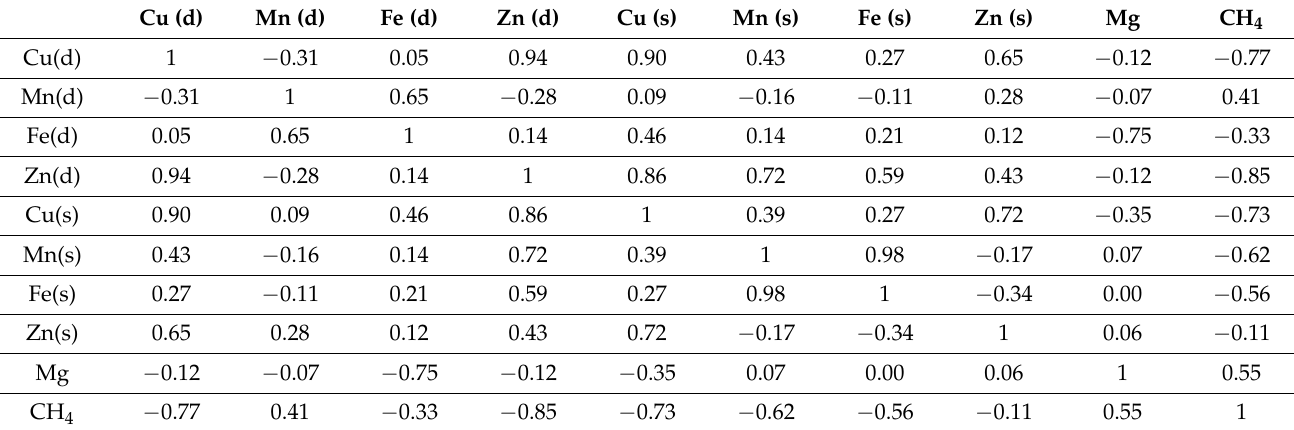
Table 5. Correlation between Mg, CH 4 , and dissolved (d) and suspended (s) ore elements in the hydrothermal plume. Hydrothermal fields: Korallovoe and